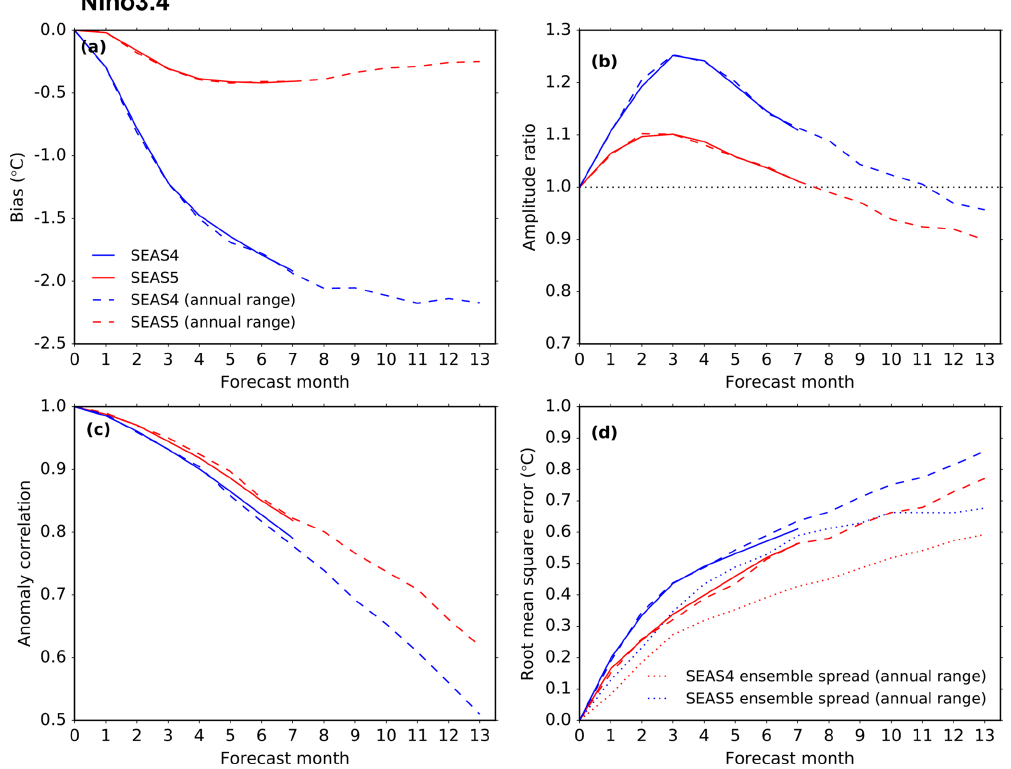
Figure 2. Forecast performance metrics (described in Sect. 3.1) of the monthly averaged Niño 3.4 index in SEAS4 (blue) and SEAS5 (red). Long-range (7-month) forecasts are shown as the solid lines, and use 15 ensemble members from each of the 12 monthly start dates. Annual- range (13-month) forecasts are shown as the dashed lines, and use 15 ensemble members from each of the four quarterly start dates. The verification data are NCEP OIv2. The top row shows (a) climatological bias and (b) ratio of the standard deviation of re-forecast and OIv2 anomalies, calculated using individual ensemble members. The bottom row shows (c) anomaly correlation and (d) RMSE (solid and dashed lines) and ensemble spread (dotted